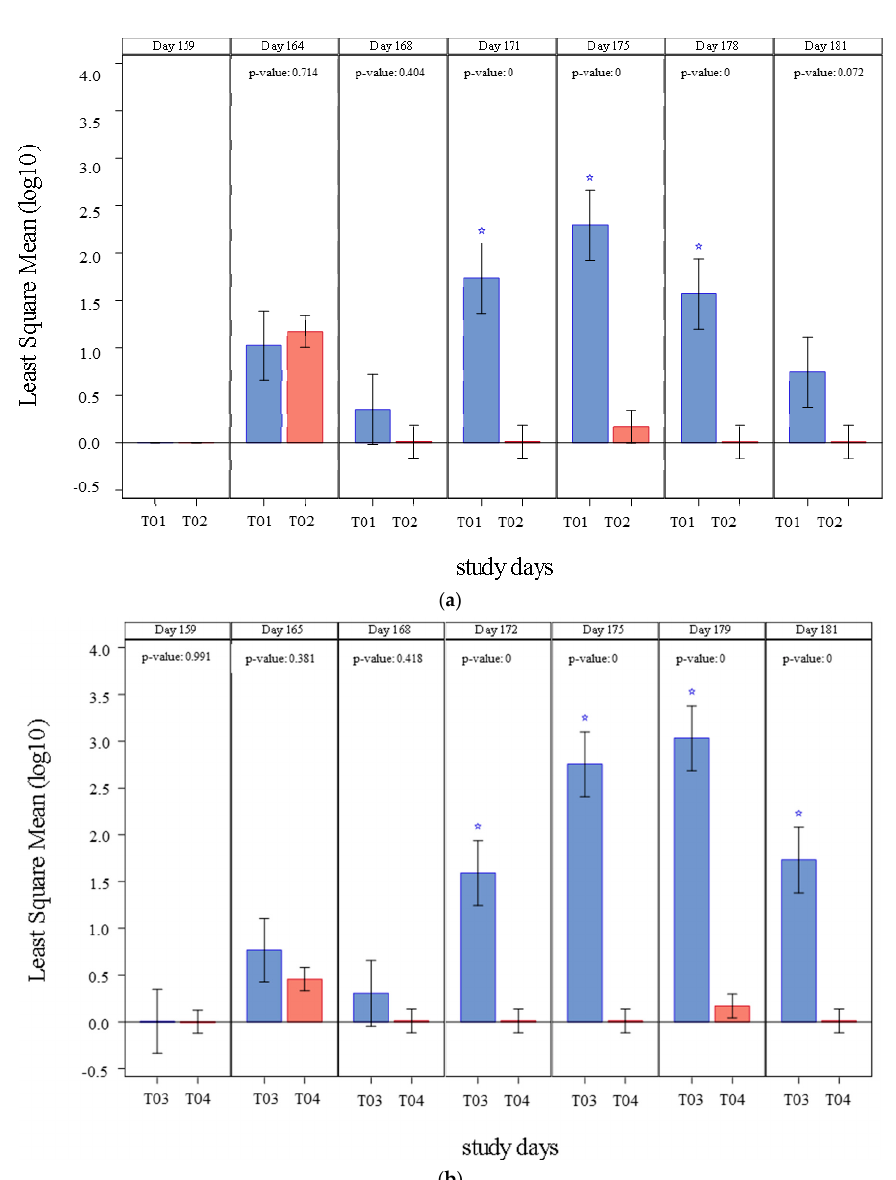
Figure 2. PCV2 fecal shedding (Least Square Mean (log 10 ) of DNA copies/mL) by treatment and day of study and significance: ( a ) PCV2 fecal shedding detected in study 1, results from T01 are represented in blue and results from T02 are represented in red. When p -value <0.0001 it is described as 0, and significant differences between groups ( p ≤ 0.05) are marked with a blue star; ( b ) PCV2 fecal shedding detected in study 2, results from T03 are represented in blue and results from T04 are represented in red. When p -value <0.0001 it is described as 0, and significant differences between groups ( p ≤ 0.05) are marked with a blue star.